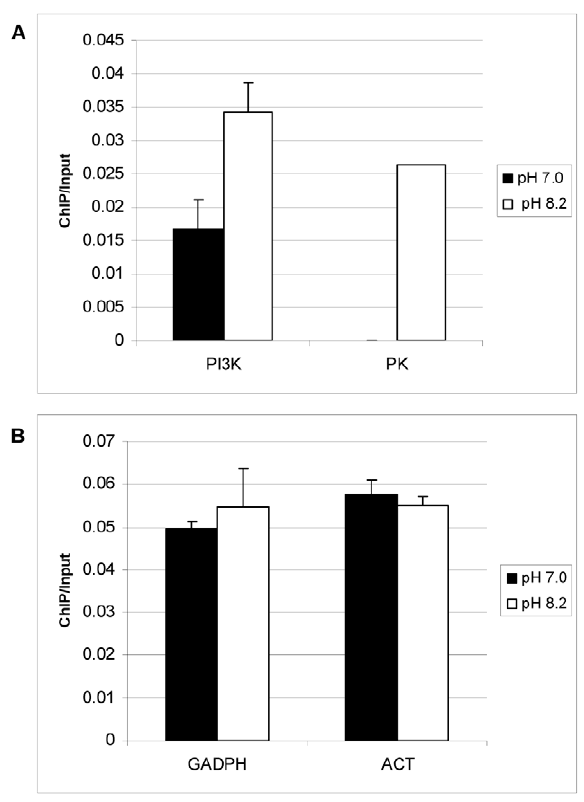
Figure 5. TgGCN5-A is enriched at genes up-regulated during alkaline pH stress. Toxoplasma parasites stably expressing FLAG- tagged TgGCN5-A were maintained in HFFs with normal (pH 7.0) or alkaline (pH 8.2) medium prior to harvesting for qChIP using anti-FLAG antibody. Immunoprecipitated DNA was examined using primers to pH responsive genes phosphatidylinositol 3- and 4-kinase (PI3K), and protein kinase (PK) (A), or housekeeping gene controls, GAPDH and actin, ACT (B). Results are represented as a ratio of ChIP/Input DNA. The difference between pH 7 and pH 8 for PI3K is statistically significant (p=0.02, Student’s